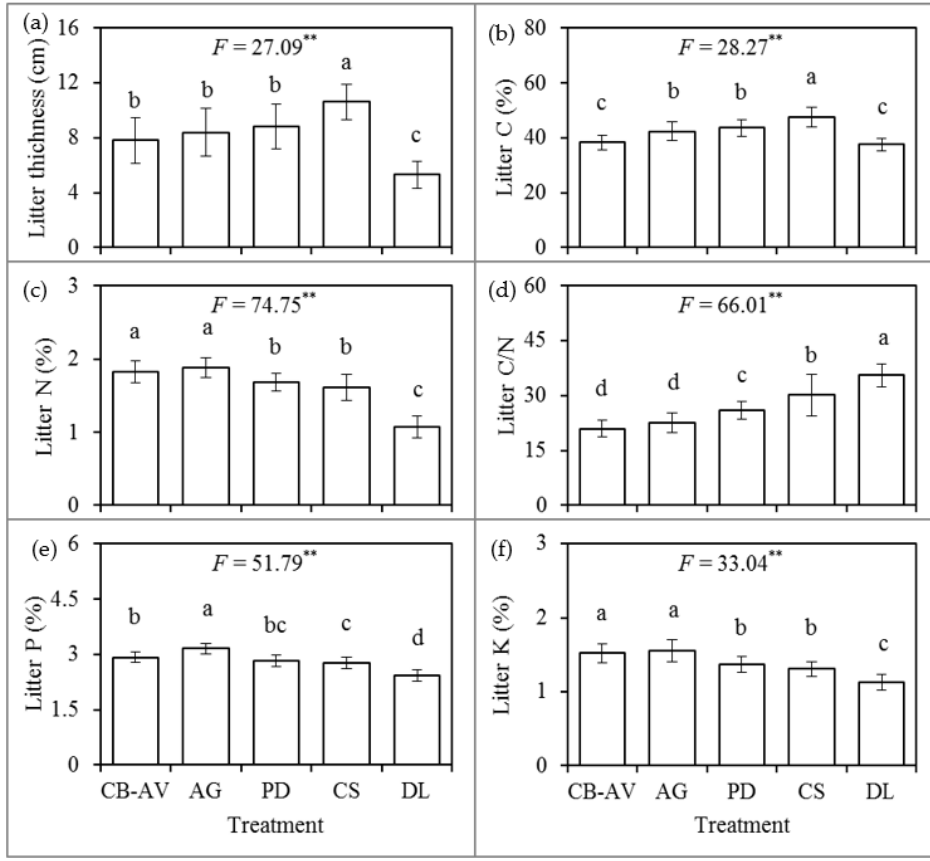
Figure 2. Mean values and standard deviation (SD) of litter properties: litter thickness ( a ), litter C ( b ), N ( c ), C/N ( d ), P ( e ), and K ( f ) in the different tree species treatments. Results of the ANOVAs ( F test and p value) are given. Different letters after means within each treatment indicate significant differences by Duncan’s test ( p < 0.05). Note: ** P < 0.01. CB ‐ AV = natural forest stand of Carpinus betulus L. ‐ Acer velutinum Boiss.; AG = plantation of Alnus glutinosa (L.) Gaertn.; PD = plantation of Populus deltoides L.; CS = plantation of Cupressus sempervirens L. var. horizontalis (Mill.) Gord.; DL = degraded land without trees.